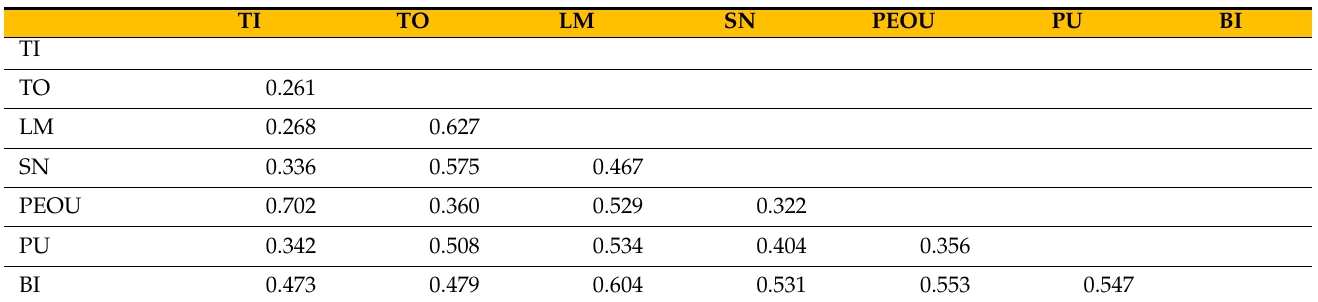
Table 5. Heterotrait–Monotrait Ratio (HTMT).